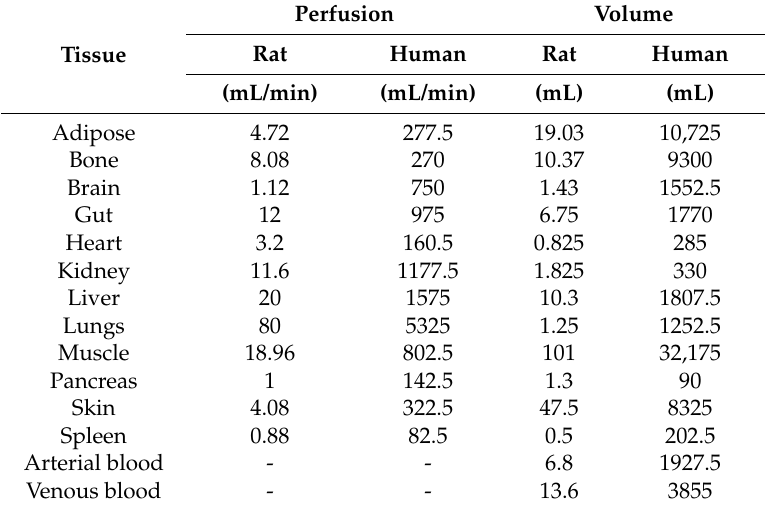
Table 1. System-related parameters used for the rat whole-body PBPK